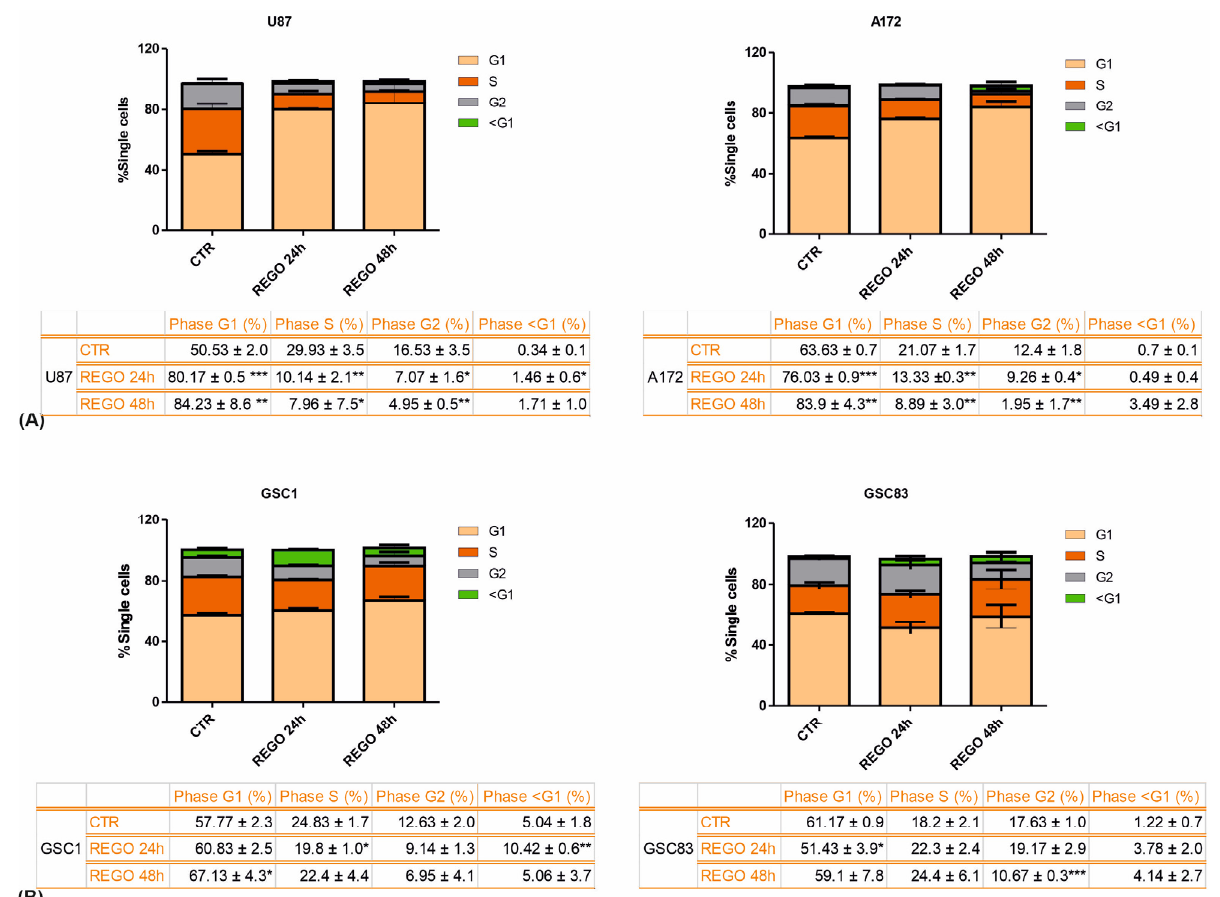
Figure 2. FACS analyses of cell cycle upon regorafenib treatment. Established cell lines ( A ) and patient-derived GSCs ( B ) were vehicle-treated (CTR) or treated with 7.5 μ M regorafenib for 24 or 48 h before fixation, propidium iodide staining, and FACS analysis. n = 3 biological replicates. * p value < 0.05; ** p value < 0.01; *** p value < 0.001.